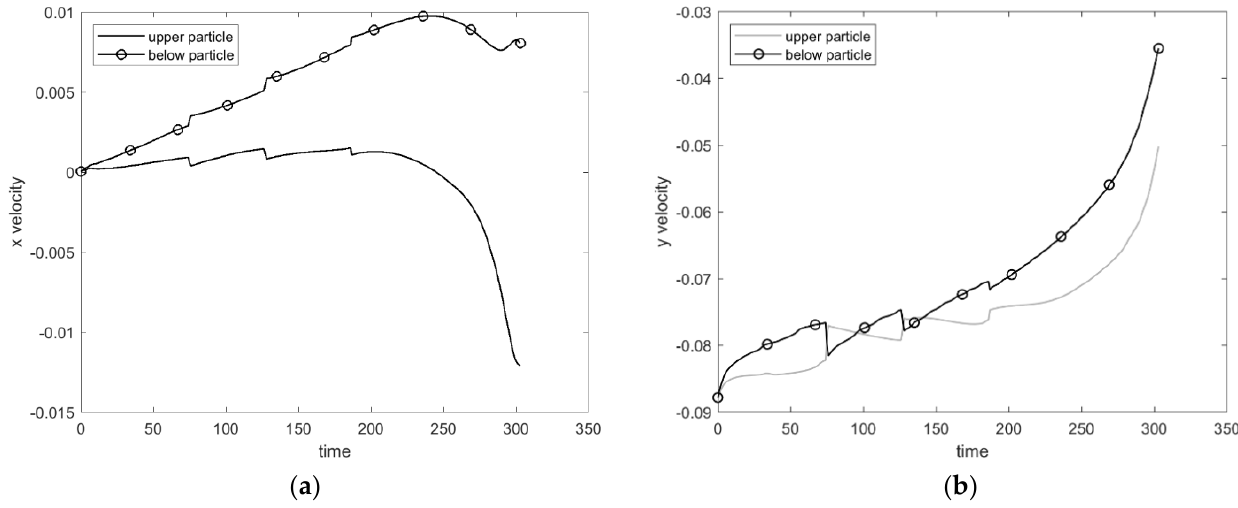
Figure 16. Velocity of two settlement particles.